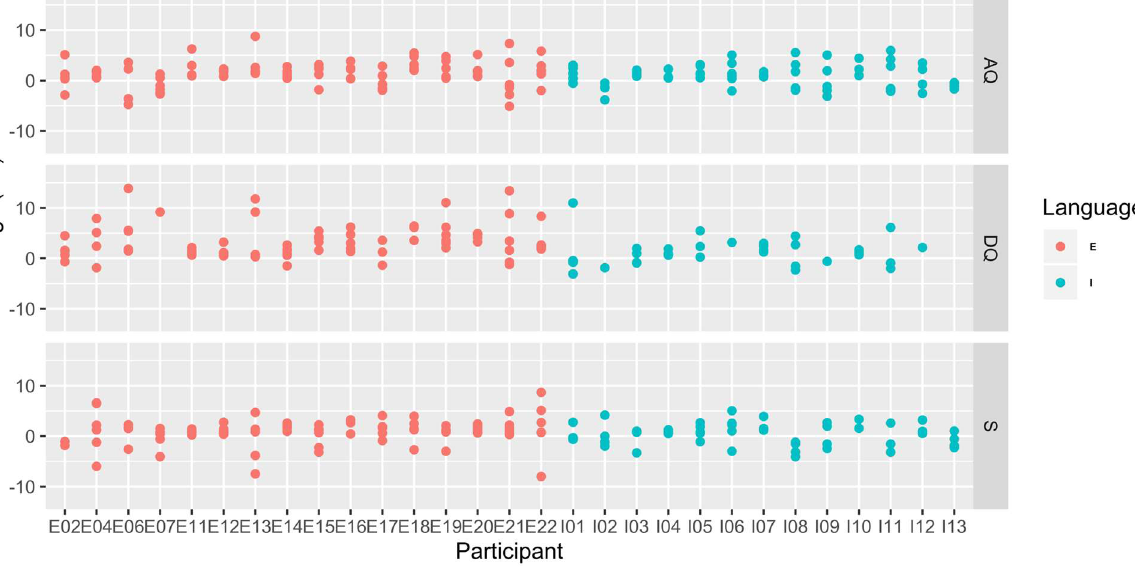
Figure 9. Pitch change in the first pitch accent (C task) in each sentence type by participant.